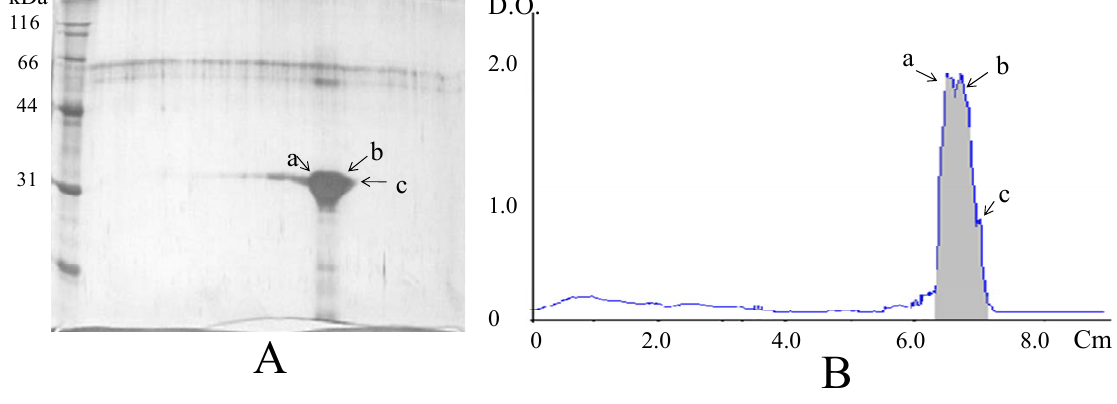
Figure 4. Analysis of the lectin from tepary beans by 2D-polyacrylamide gel electrophoresis. ( A ). In the gel shown, three distinct species (designated as a, b, and c) were distinguished; ( B ). Densitogram shows peaks corresponding to the three species, with calculated isoelectric points of 4.5 (a), 4.4 (b), and 4.2